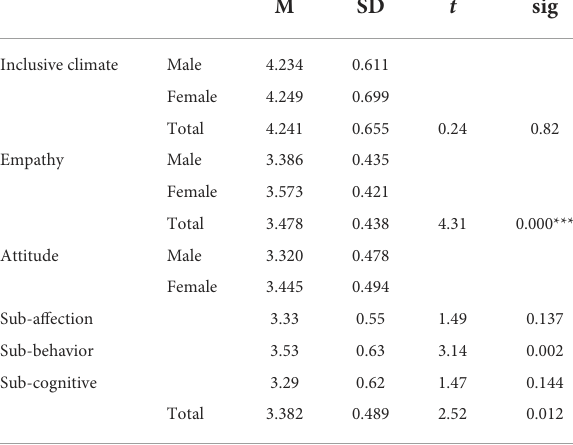
TABLE 3 Descriptive data of variables.